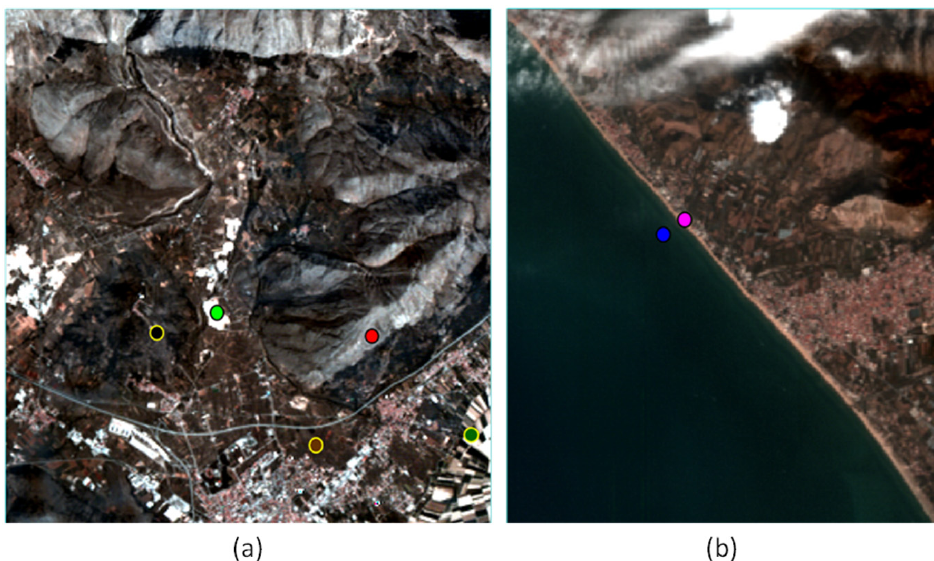
Figure 14. Location of the selected points for spectral signature comparison: ( a ) Alba Fucens (green: pit; red: rock; dark green: light soil, brown: dark soil; black; Alba Fucens soil); ( b ) Sinuessa (blue: sea; pink: sand).